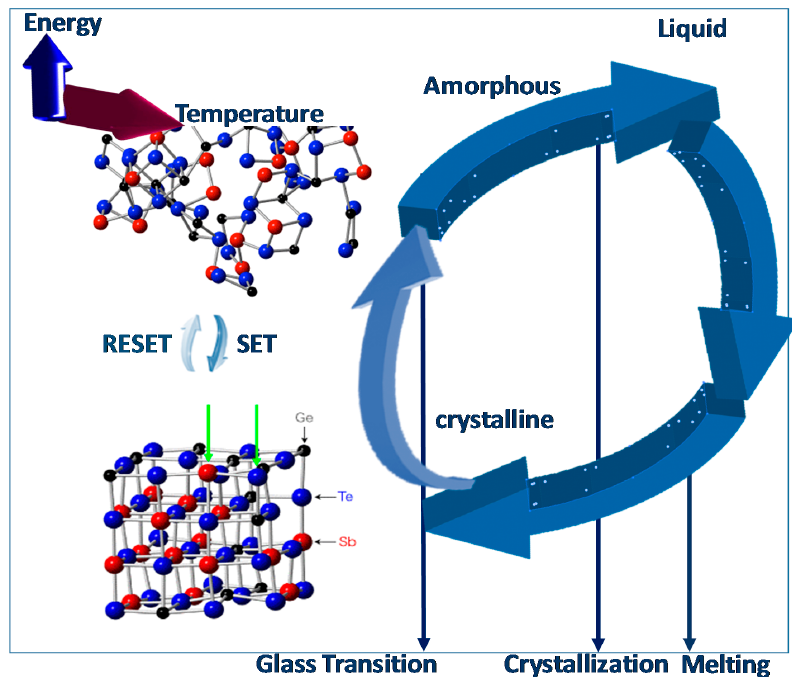
Figure 2. Schematic illustration of phase transition of GST between amorphous and crystalline phases.